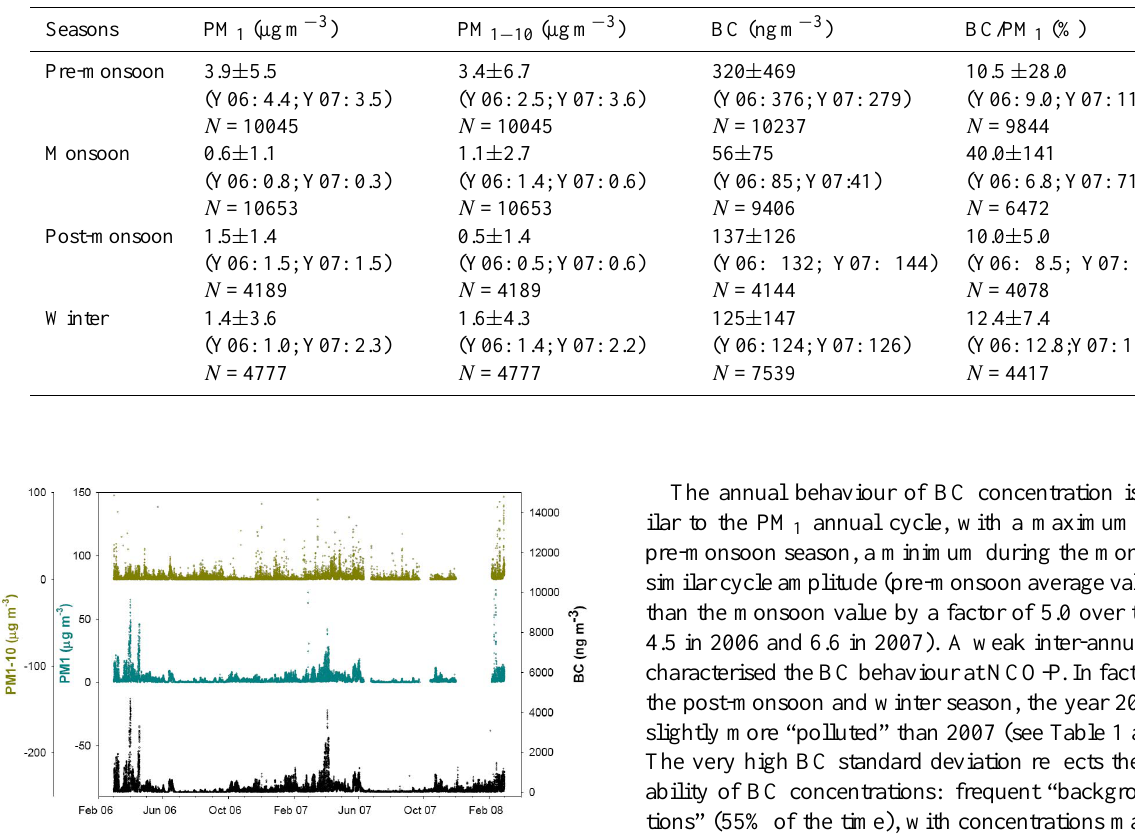
Table 1. Seasonal average and standard deviation for BC, PM 1 , PM 1 − 10 (30-min averaged values). In brackets, the annual average values for 2006 (Y06) and 2007 (Y07) are also reported. N represents the number of averaged values.